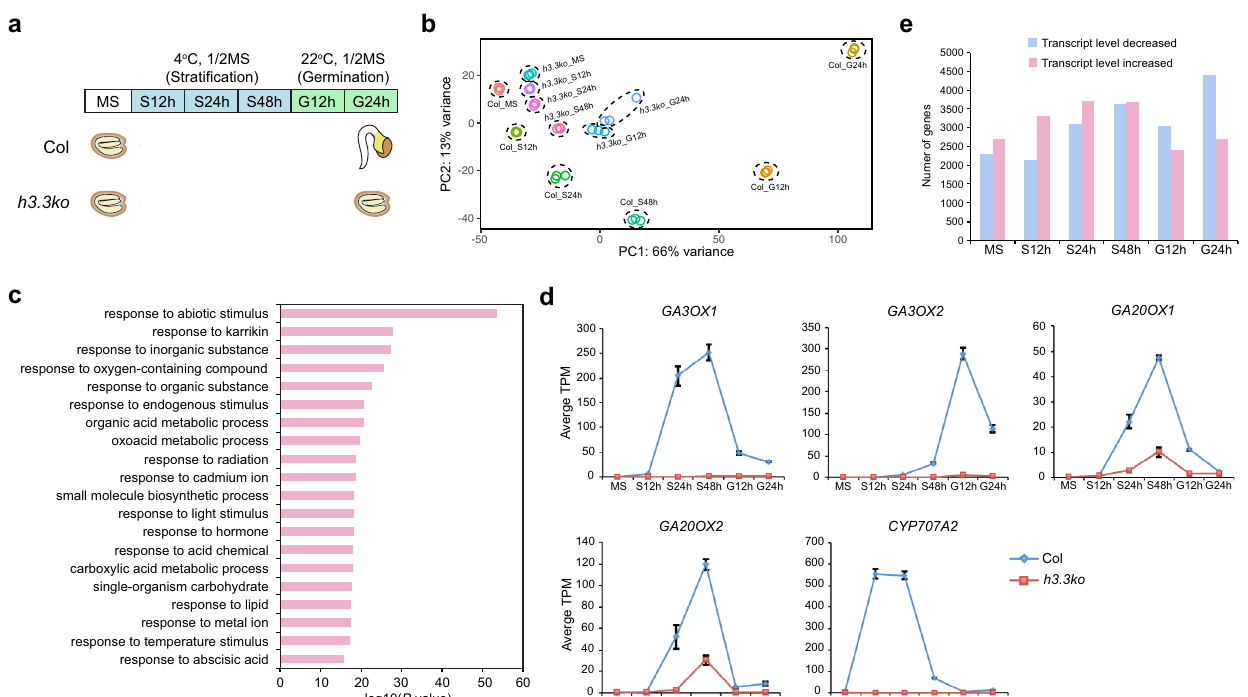
Fig. 2 | Transcriptome changes in h3.3ko . a The germination time course in this study. MS: mature seeds, S12h/S24h/S48h: strati fi ed for 12/24/48h, G12h/G24h: subjected to germination for 12/24h. At G24h, the germination of Col but not h3.3ko has been completed. b PCA plot of Col and h3.3ko seeds imbibed for dif- ferent times showing their transcriptome differences determined by RNA-seq. PC1 covers the highest amount of variance between samples; PC2 covers most of the remaining variance. Three biological replicates were performed for each line at each time point. c GO analysis of a combined set of all signi fi cantly misexpressed